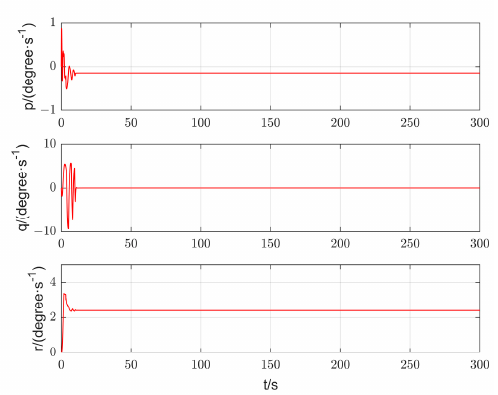
Figure 15. Angular velocity curves with FOPID.